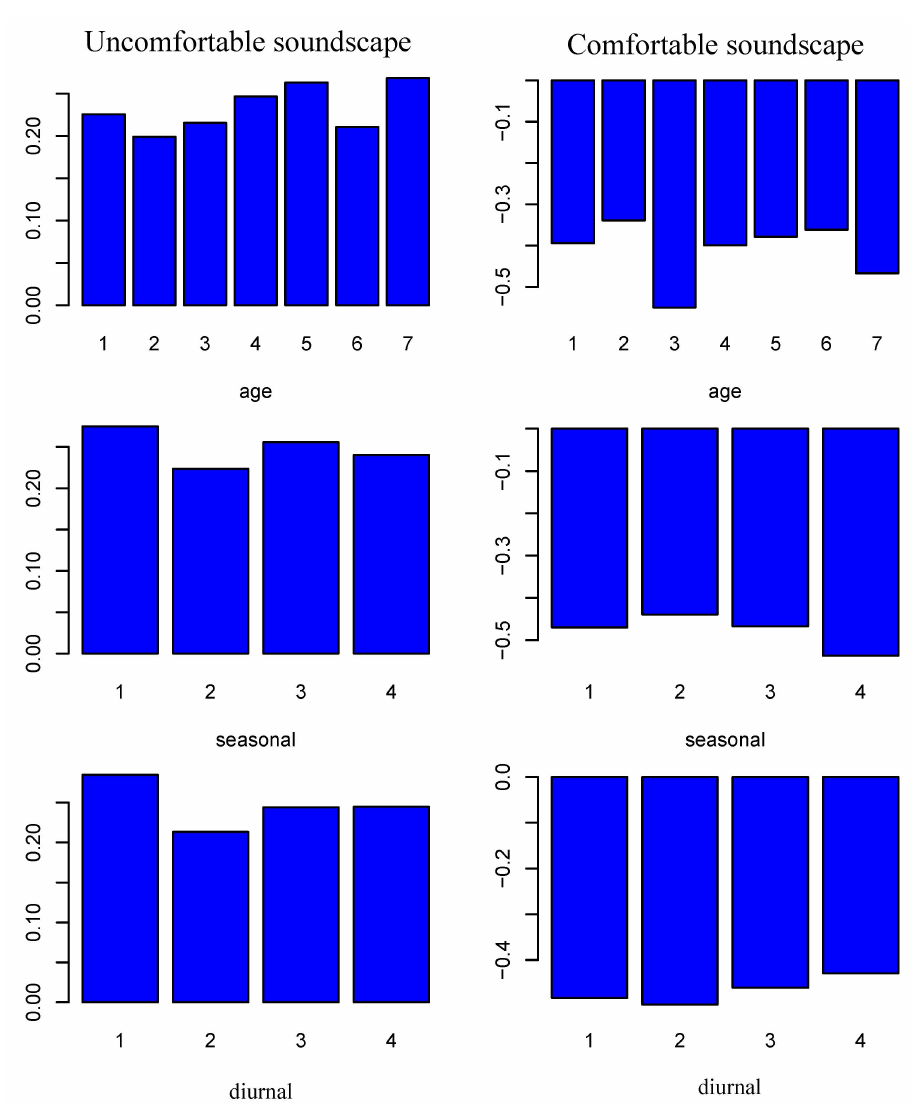
Figure A5. Partial dependence plot to understand the marginal effect of a single predictor on model prediction